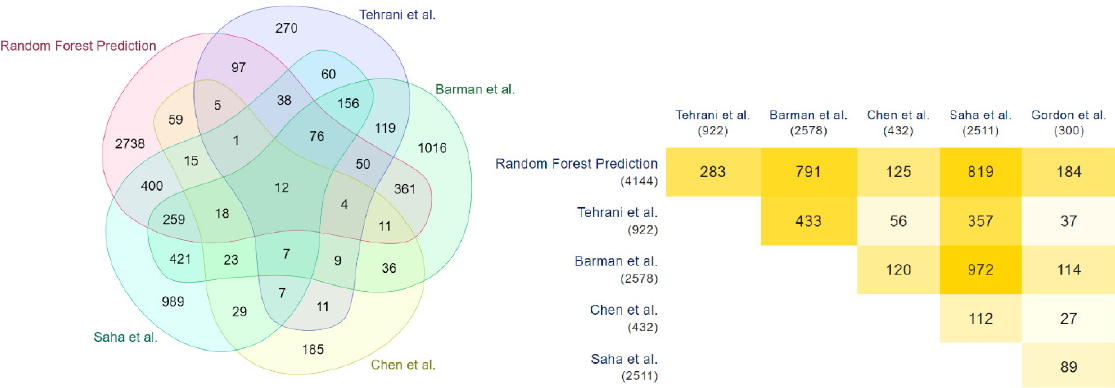
Figure 6. Overlapping of Random Forest and other methods predicted COVID-19 human drug targets.